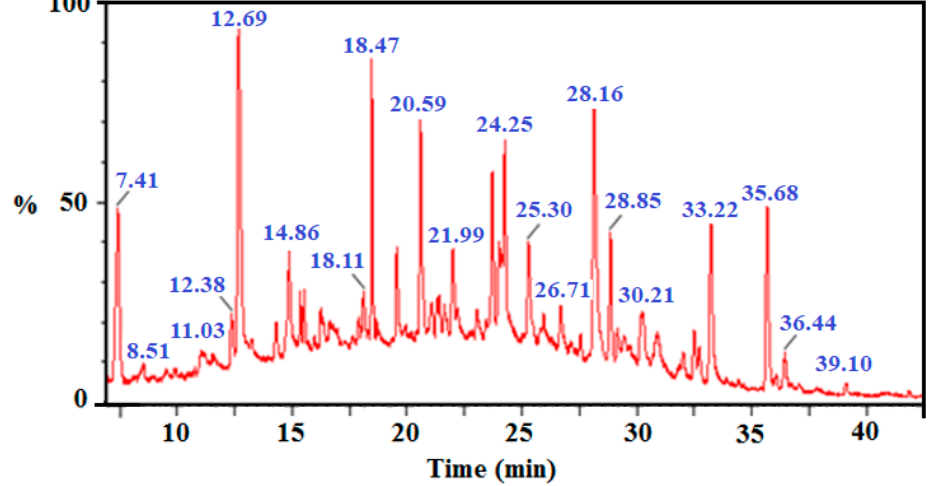
Figure 9. Total ion chromatogram of mixture of four chlorphenols (2-CP, 2,4-DCP, 2,4,6-TCP and 2,3,4,5-TeCP) after 120 min illumination time.